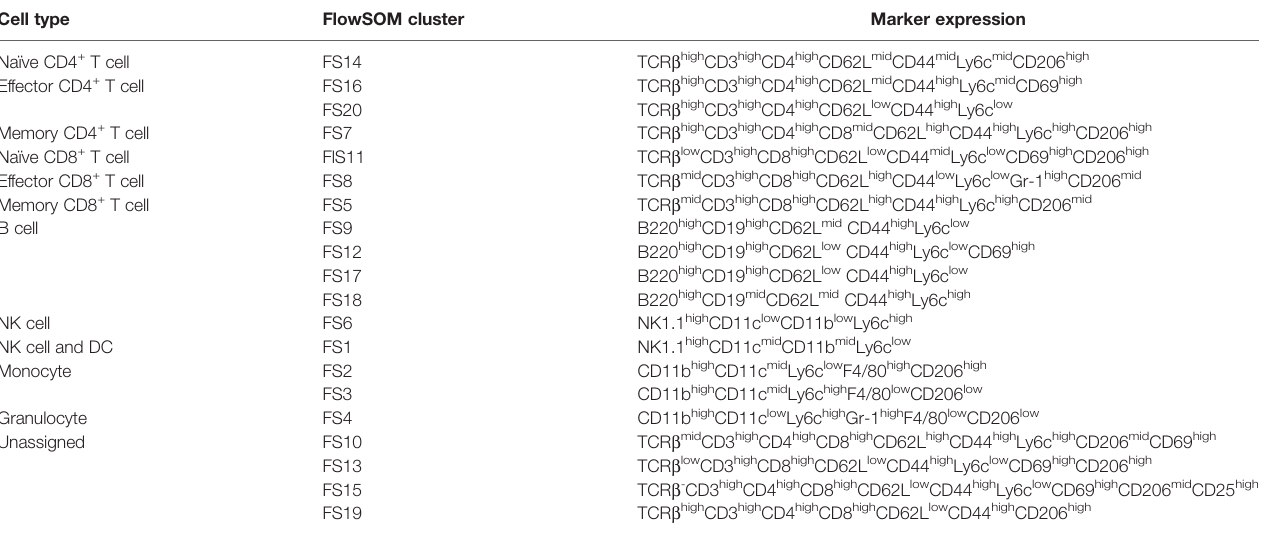
TABLE 3 | Comparison of FlowSOM clusters with manually gated cell phenotypes and associated marker expression. Cell